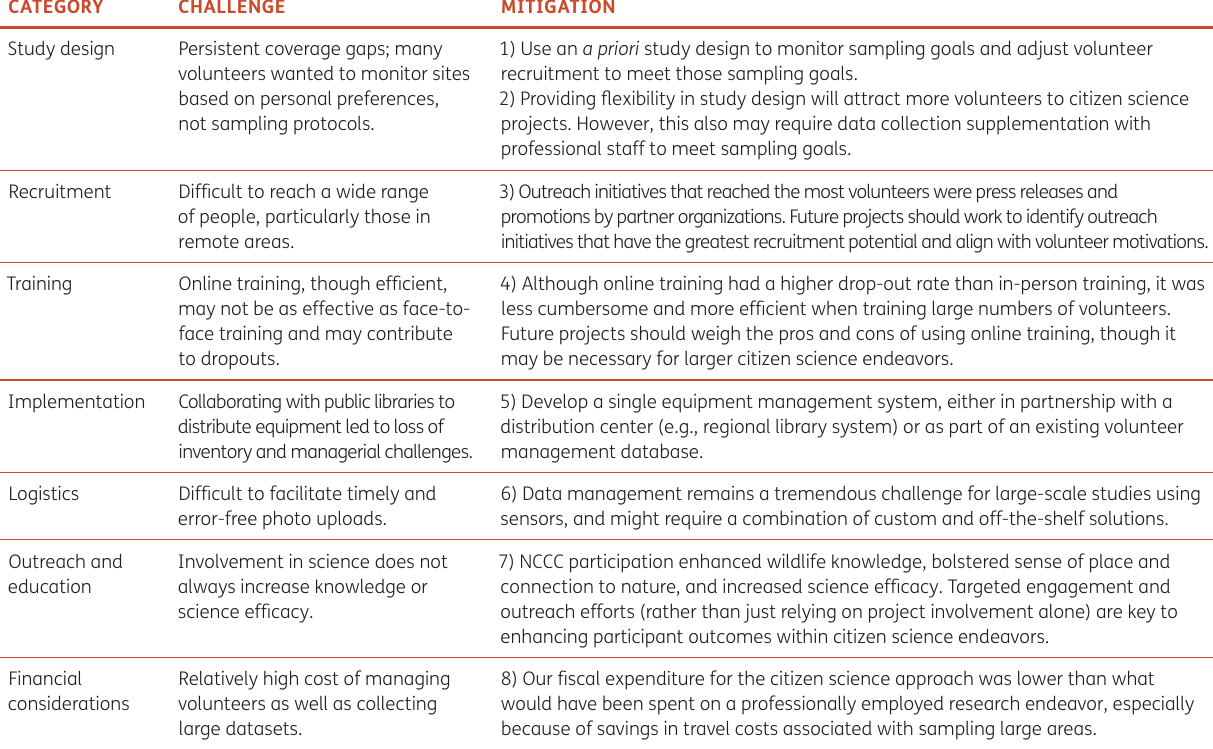
Table 2 Challenges and potential solutions for citizen science projects using camera traps to gather large-scale datasets (based on insights from North Carolina Candid Critters